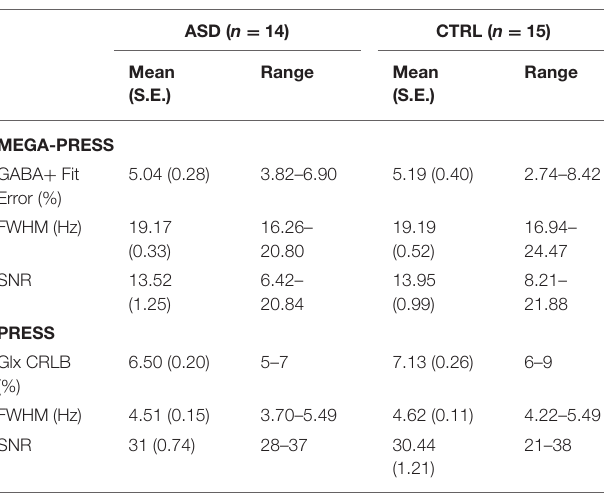
TABLE 2 | MRS data quality